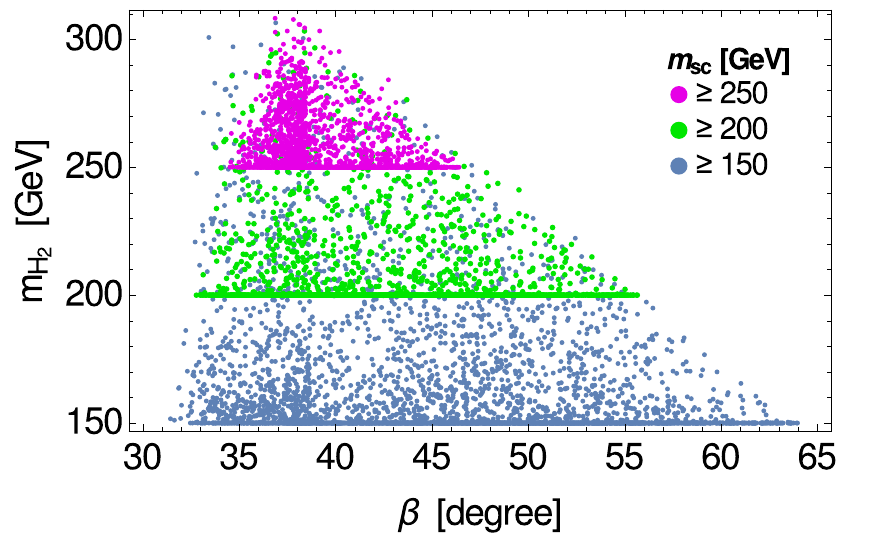
Figure 4 . Scatter plot of m H versus the angle β . Blue points have all the scalar masses, except 2 m H = 125 GeV, higher than 150 GeV; green points have all those masses higher than 200 GeV, 1 and magenta points have all of them higher than 250 GeV.